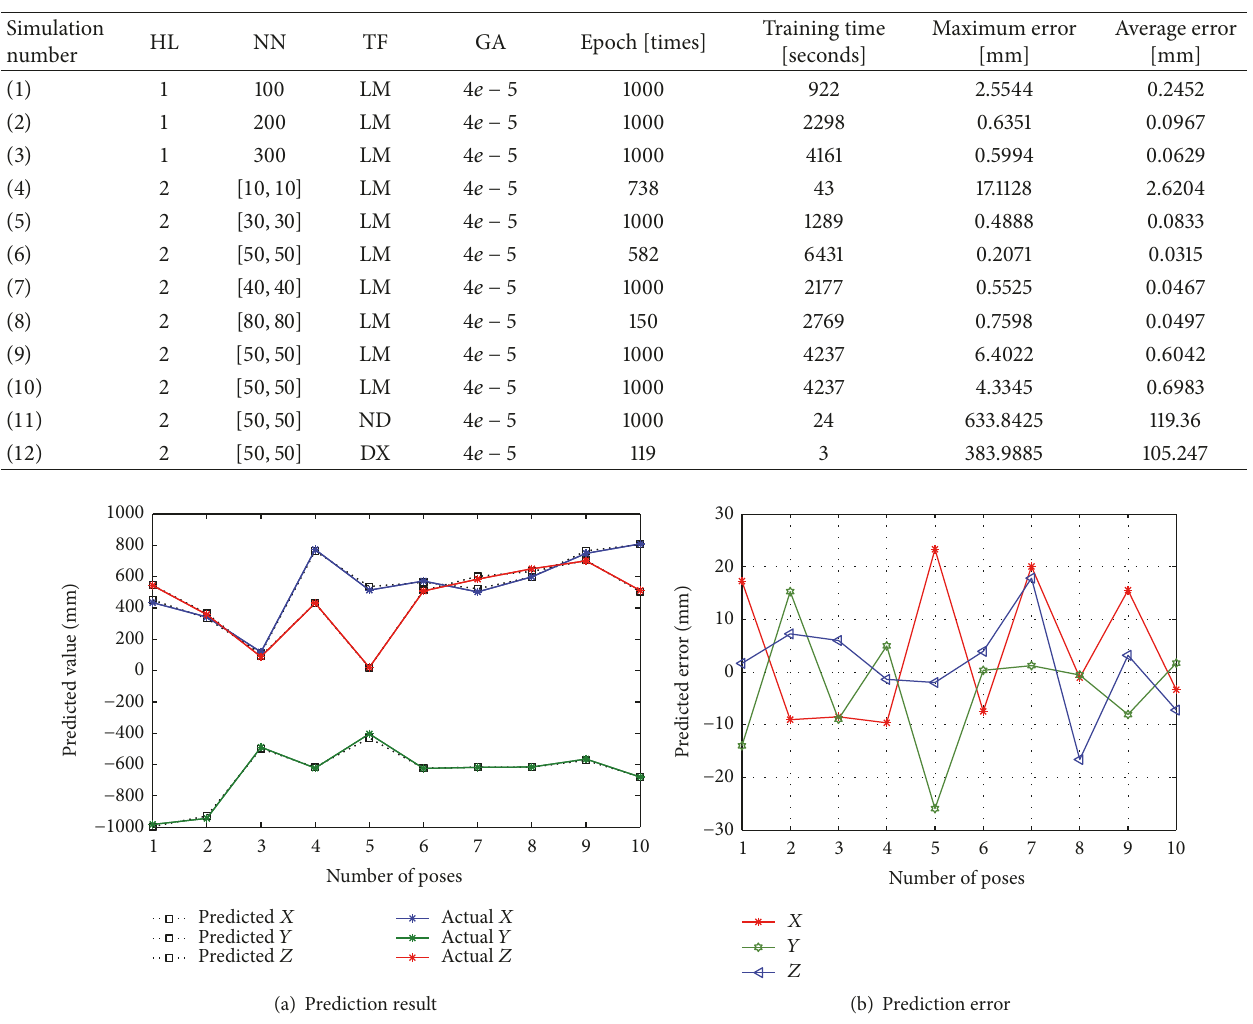
Figure 4: The prediction result and prediction error of the simulation number (1).